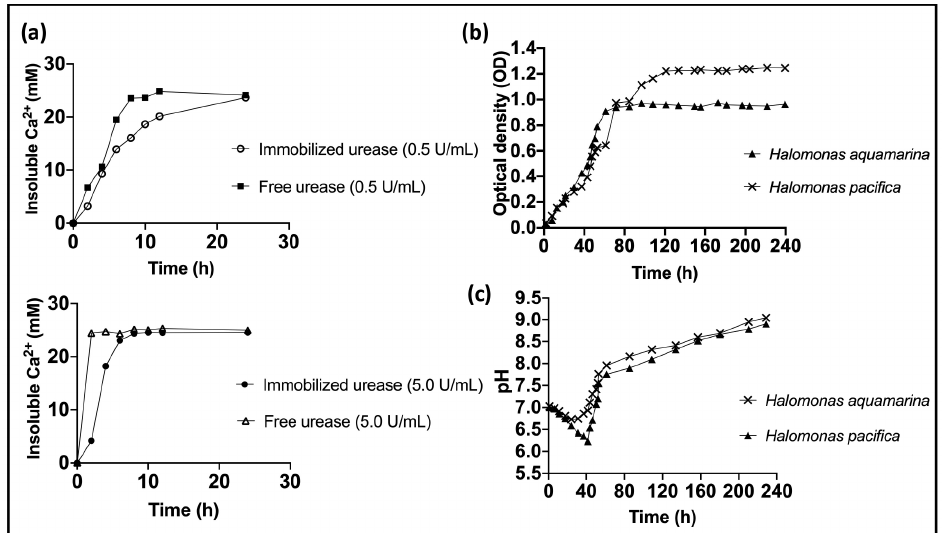
Figure 4. ( a ) Different concentrations of the enzyme affected proportionally the concentration of mineral synthesized. The biological accessibility of the enzyme, comparing free B. pasteurii ’s urease expressed by a transformed E. coli strain (free urease) and urease partially purified and immobilized in polyurethane (PHU) foam (immobilized urease), also affected the concentration of insoluble Ca 2+ (adapted from Bachmeier et al. (2002) [124]). ( b ) Microbial growth interpreted as optical density correlated directly to higher concentrations of catalytic enzymes that influence the amount of biominerals synthesized in the biomineralization model of species Halomonas (adapted from Sanchez- Roman et al. (2007) [65]). ( c ) Changes in pH from neutral to alkaline associated to the growth and biomineralization performance of Halomonas (adapted from Sanchez-Roman et al. (2007) [65]).